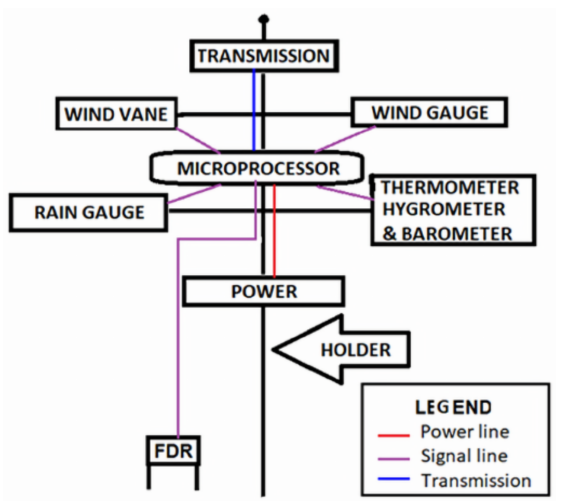
Figure 1. Node structure: Application to a meteorological